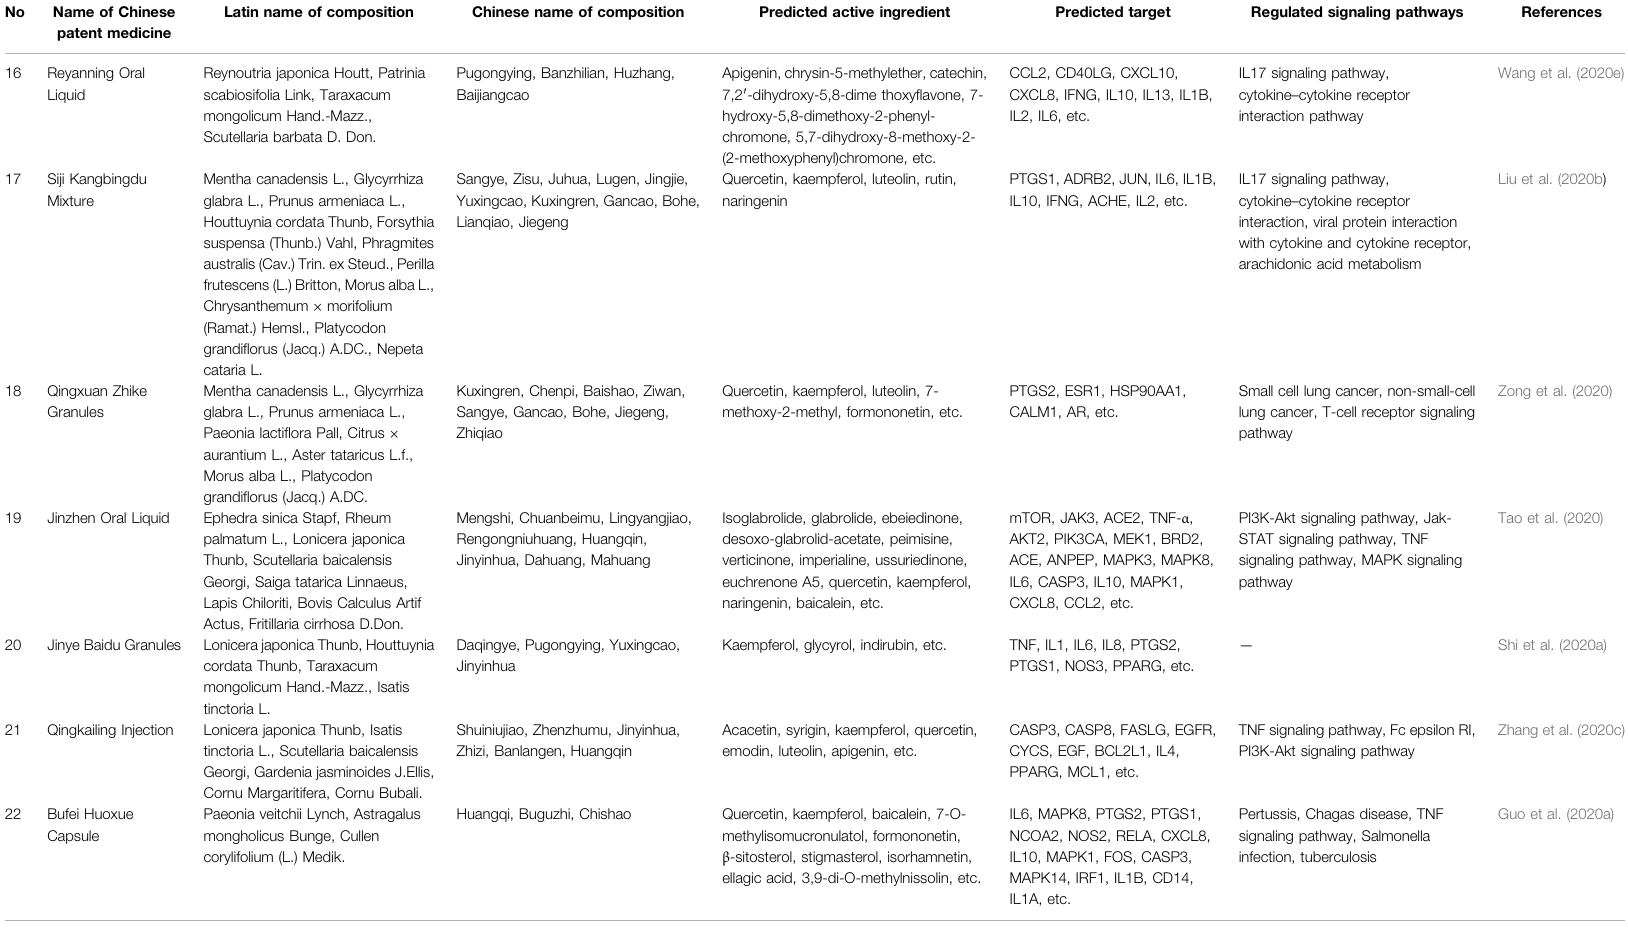
TABLE 3 | ( Continued ) Summary of potential action mechanisms of CPMs for